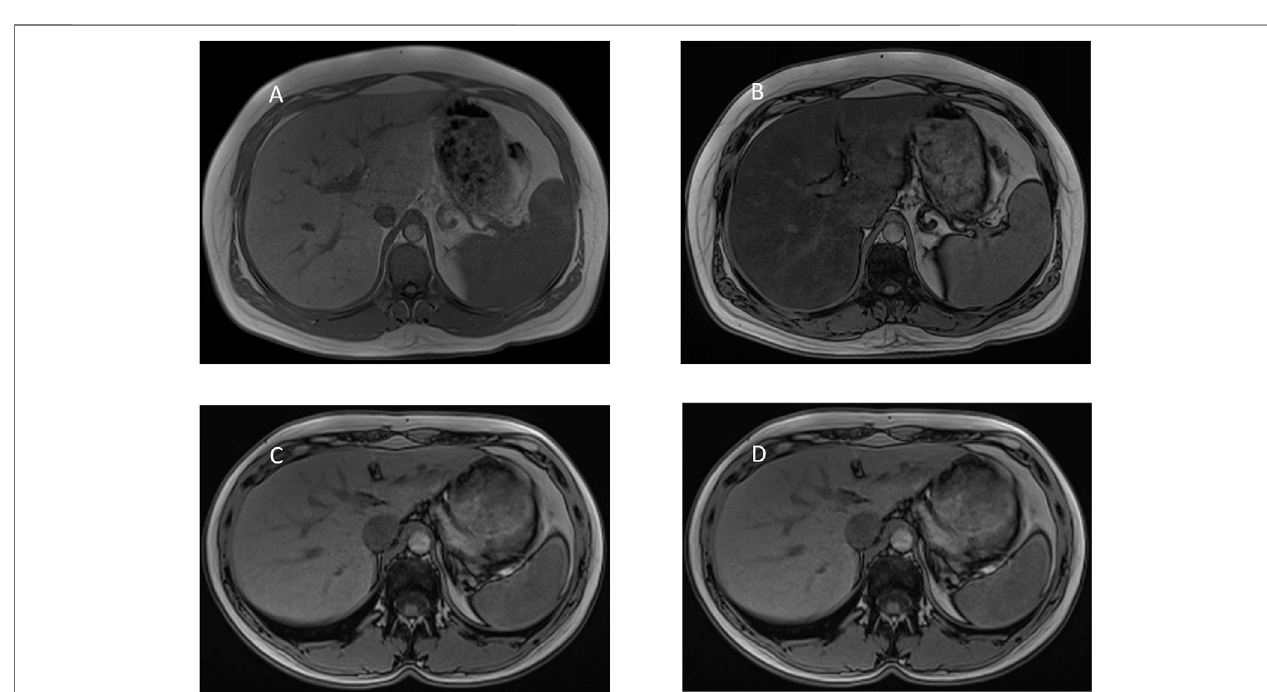
FIGURE 4 | MRI-imaging features of liver steatosis. Caption: MRI proton chemical shift imaging with (A) in-phase T1-weighted gradient-echo image showing normal signal intensity of the hepatic parenchyma and (B) opposed-phase T1-weighted gradient-echo image showing a marked drop in signal intensity of the hepatic parenchyma, indicating diffuse hepatic steatosis. In contrast, MRI proton chemical shift imaging with (C) in-phase and (D) opposed-phase T1-weighted gradient-echo image showing normal signal intensity of the hepatic parenchyma indicating the absence of steatosis. In GlyH, as described by Saikusa et al., there is no drop in intensity either between in- and out-of-phase